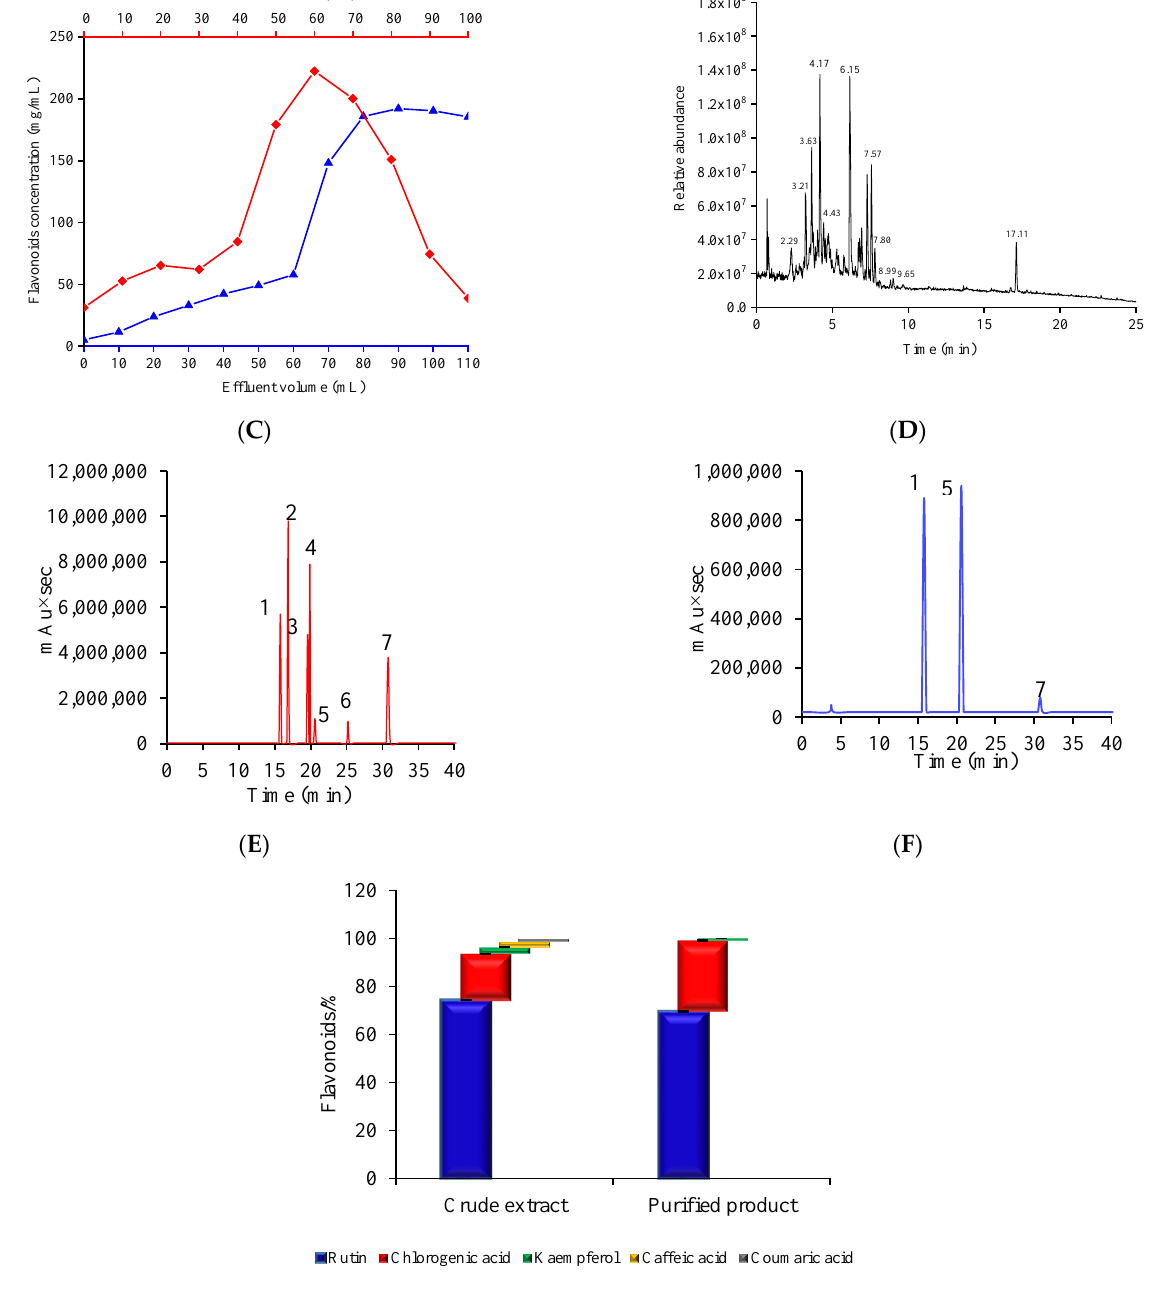
Figure 1. Isolation, purification and identification of LBLF. Adsorption rate of LBLF at different concentrations and flow rate ( A ). Desorption ratio of LBLF at different elution concentrations and flow rate ( B ). Dynamic adsorption and desorption curves of LBLF ( C ). The total ion chromatography of 11 flavonoids ( D ). The mixed standards ( E ) and ( F , G ) purified components of LBLF. 1−chlorogenic acid, 2−caffeic acid, 3−p−coumaric acid, 4−ferulic acid, 5−rutin, 6−quercetin, 7−kaempferol.